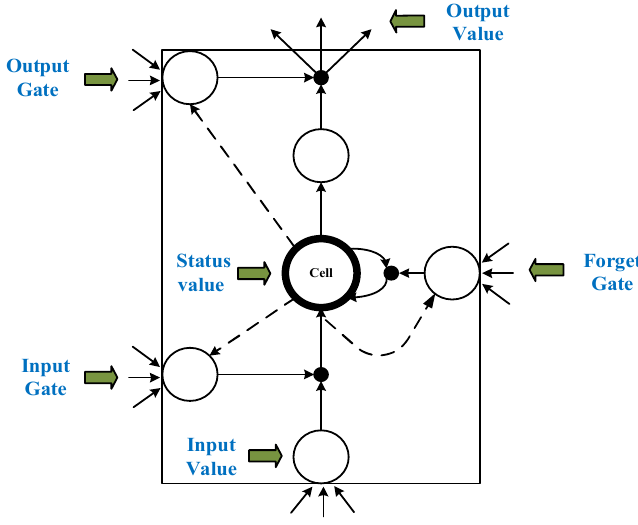
Figure 13. Long short-term memory (LSTM) unit structure.